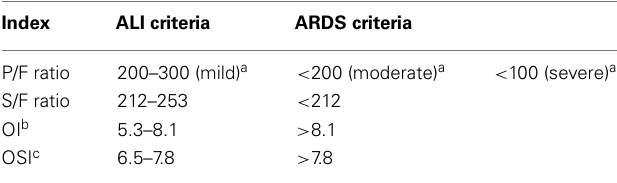
Table 1 | Respiratory indices used to defineALI/ARDS